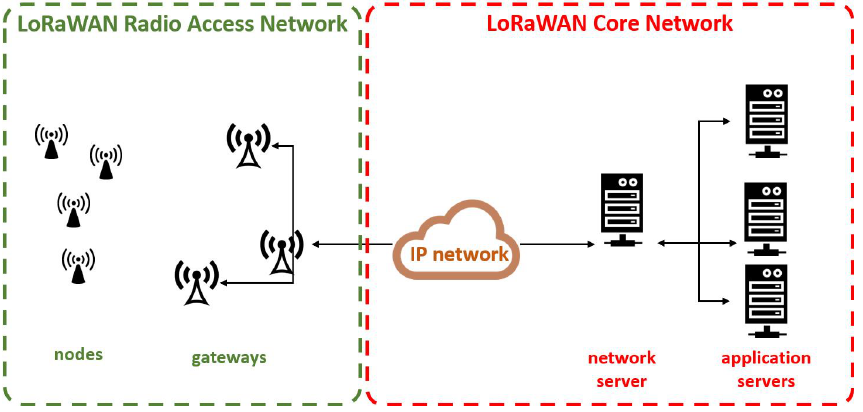
Figure 1. LoRaWAN network